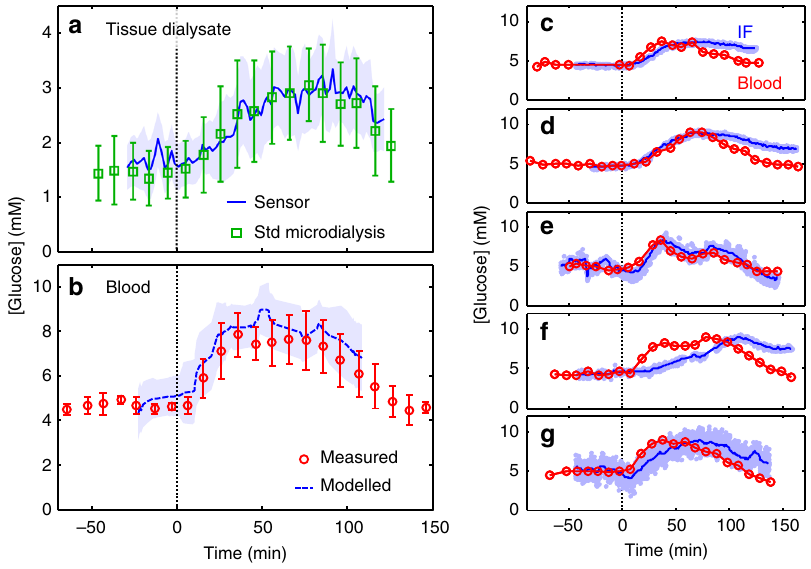
Fig. 4 In vivo measurement of glucose in subcutaneous interstitial fl uid. a Average ( n = 5) dialysate glucose measured by the sensor (blue line and shaded area) and standard microdialysis sampling and of fl ine analysis (green squares and error bars). Each is shown as a function of time since oral glucose administration (vertical dashed line, t = 0) and the error bars/area represent the standard deviation from subject-to-subject variation. b Mean ( n = 5) venous blood glucose (red circles and error bars) shown as a function of time since oral glucose administration (vertical dashed line, t = 0). The error bars represent the standard deviation from subject-to-subject variation. The blue dashed line indicates the blood glucose predicted from the sensor data calculated using a two-compartment model 37,38 (see Methods and Supplementary Fig. 14). The shaded blue area show the standard deviation of the model output, while the dashed blue is a running average (median ± 20 min). c – g Plots showing the blood glucose (red circles) and estimated interstitial fl uid glucose (IF, light blue points with blue line showing a rolling average) for each